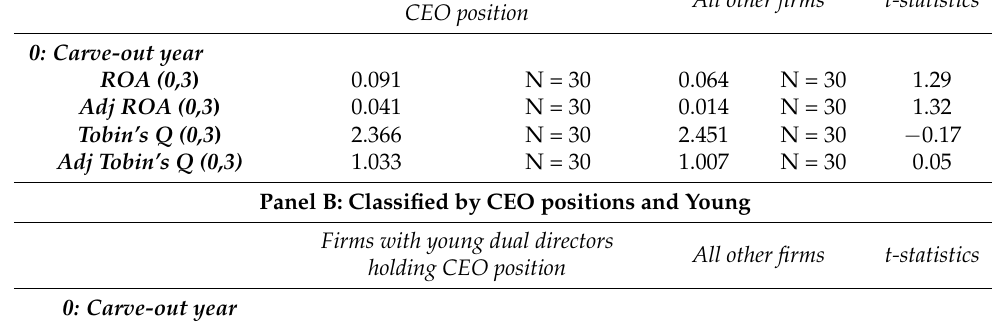
Table 6. Dual directors and subsidiaries’ performance after carve-outs. This table reports propensity score matching results of subsidiaries’ performance after carve-outs. It presents a comparison between firms with dual directors and those without. For each firm with at least one dual director, one nearest matching firm is chosen from all the other firms based on the propensity score by probit estimation. Carve-out subsidiaries’ characteristics including CEO Age, the Majority control dummy, Underpricing, CEO ownership, Ln (Total Assets), Leverage, CAPEXP, Tangible Asset, are used to compute the covariate in the probit estimation. ROA (0,3) is the average ROA from the 0 year to the +3 year. Adj ROA (0,3) is the average of the industry-mean adjusted ROA from the 0 year to the +3 year. Tobin’s Q (0,3) is the average Tobin’s Q from the 0 year the to +3 year. Adj Tobin’s Q (0,3) is the average of the industry-mean adjusted Tobin’s Q from the 0 year to the +3 year. t-statistics are used for the mean difference test. *, ** indicate significance at the 10%, 5% levels, respectively. Panel A: Classified by CEO positions Firms with dual directors holding CEO